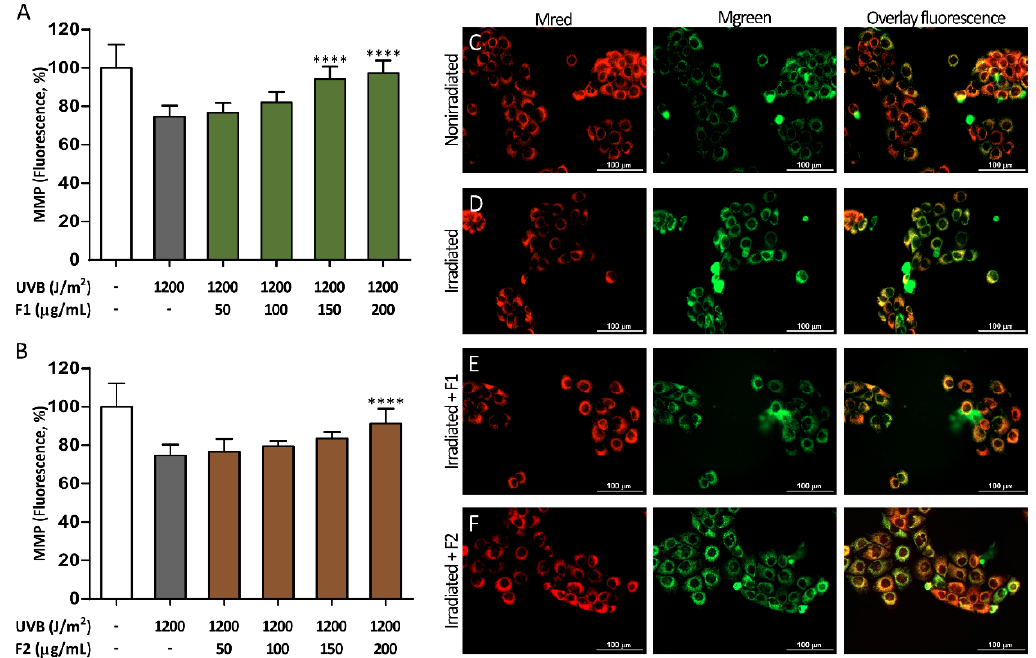
Figure 5. Mitochondrial membrane potential (MMP) restoration exerted by formulations F1 ( A ) and F2 ( B ) in HaCaT cells after UVB irradiation. MitoTracker Red CMXRos (Mred) and MitoTracker Green